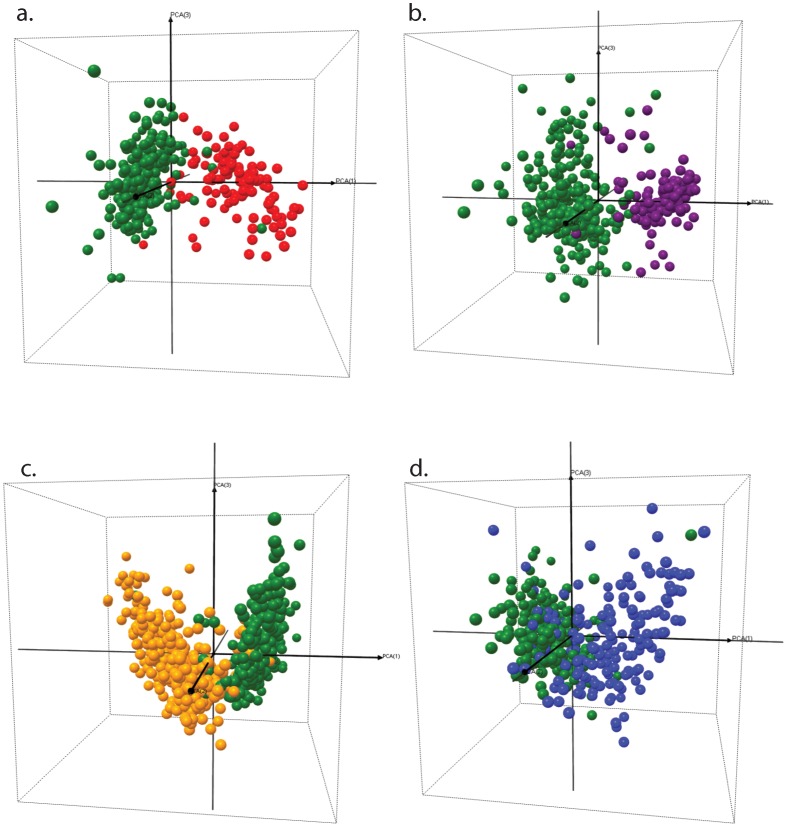
Visualization of community control (CC, non-parasitaemic) children versus other study groups.Each sphere represents an individual child proteome profile plotted in 3D space defined by the first three principal components. CM = Cerebral Malaria (red); SMA = Severe Malarial Anemia (purple); UM = Uncomplicated Malaria (yellow); DC = Disease Controls (blue); CC = Community Controls (green). (a.) CC vs. CM; (b.) CC vs. SMA; (c.) CC vs UM and (d.) CC vs. DC.